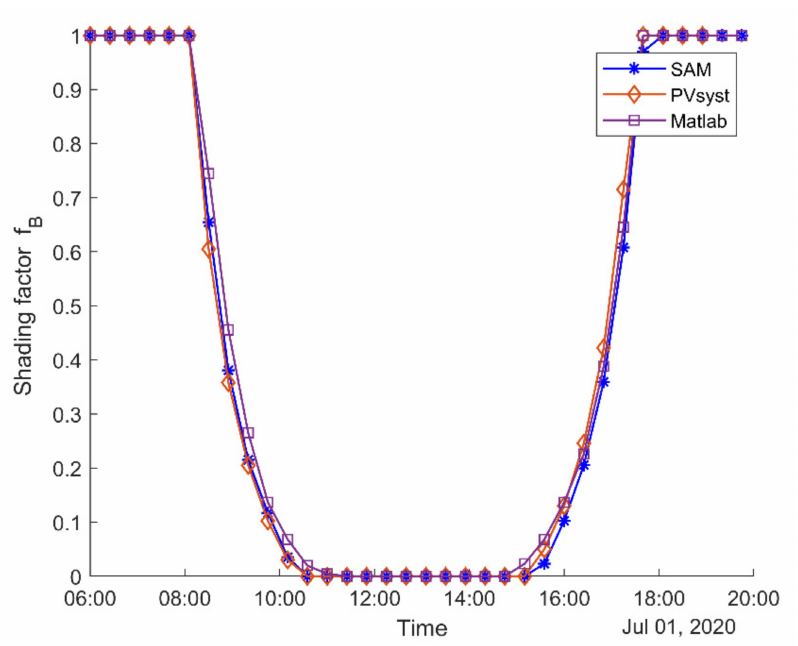
Figure 16. Shading factor f B for situation 2 calculated for one day (1 July). f B was calculated with the System Advisor Model (SAM), PVsyst, and the proposed Matlab